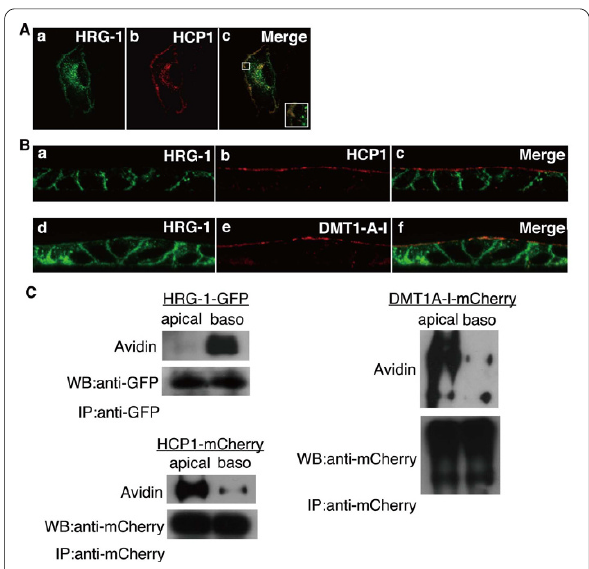
Figure 6 Subcellular localizations of HRG-1, HCP1, and DMT1A-I in polarized or non-polarized MDCK cells . A. GFP-tagged HRG-1 (a) or mCherry-tagged HCP1 (b) were cotransfected into HEp-2 cells. The cells were cultured on glass coverslips for 48 h after replating. B. MDCK cells stably expressing GFP-tagged HRG-1 (a and d) and mCherry- tagged HCP1 (b) or mCherry-tagged DMT1A-I (e) were grown on Tran- swell and analyzed after their polarization. C. Cell surface labeling as- say. MDCK cells stably expressing GFP-tagged HRG-1, mCherry-tagged HCP1, or mCherry-tagged DMT1A-I were grown on Transwell, and each apical or basolateral surface proteins were biotinylated. The bioti- nylated proteins were immunoprecipitated with protein A conjugated with anti-GFP or anti-mCherry polyclonal antibodies, and analyzed by Western blot. Similar results were obtained in 3 independent experi-